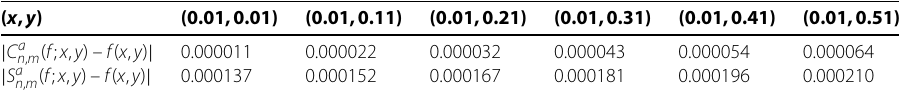
Table 2 Error of approximation for C a n , m and S a n , m